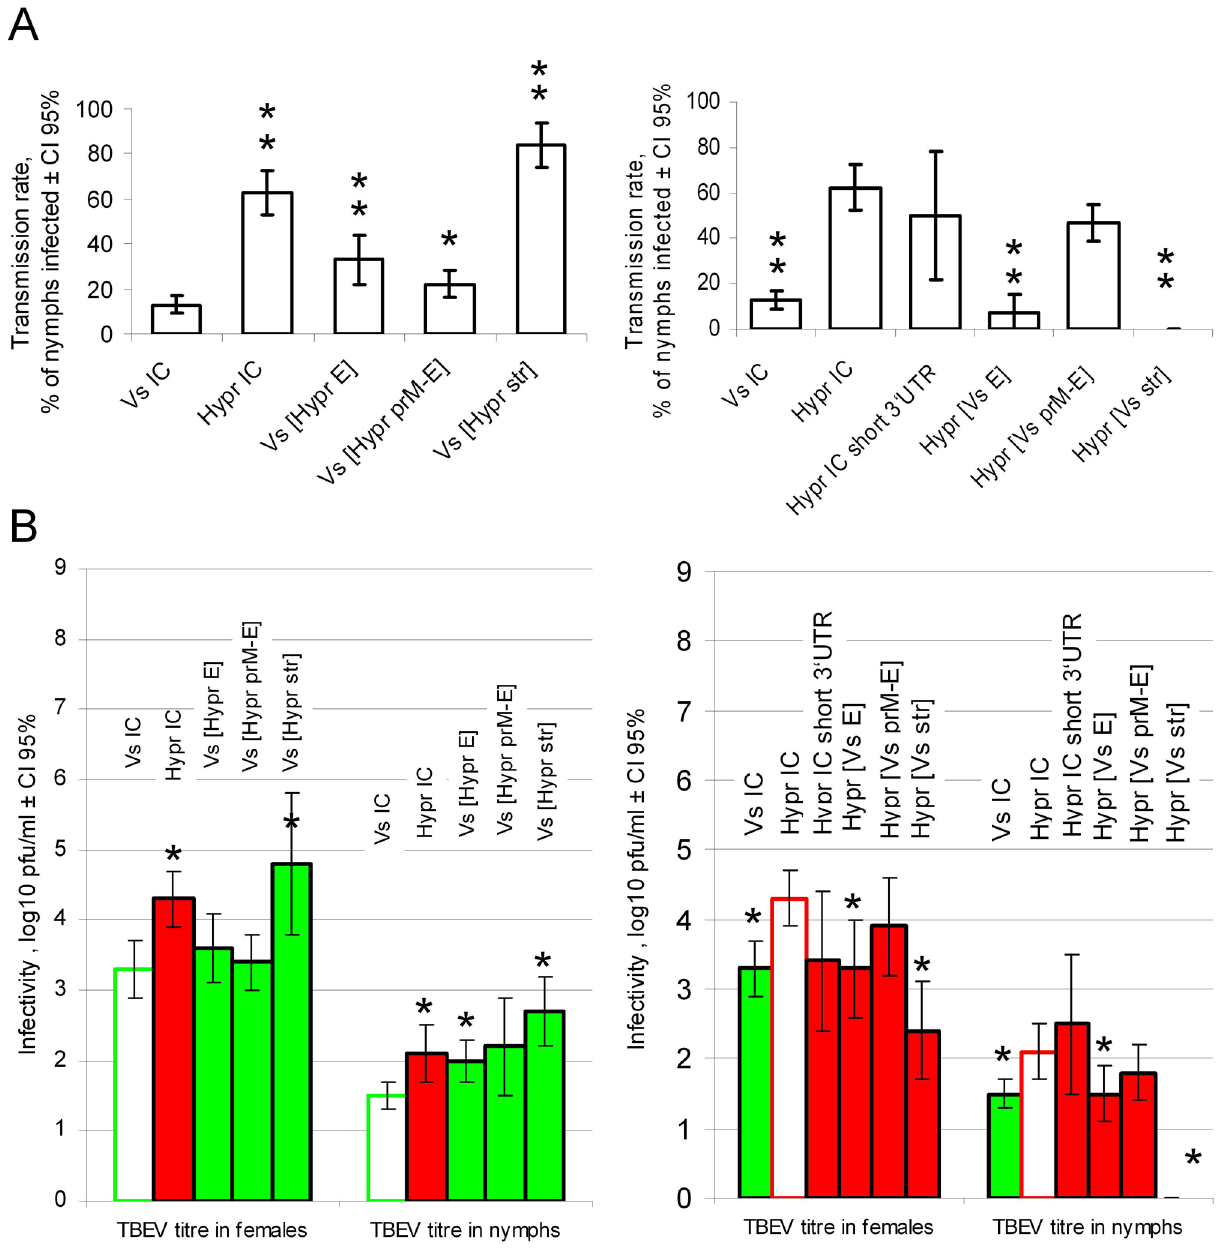
Fig 6. TBEV transmission and replication in I . ricinus ticks. Each adult tick female was injected with 500 pfu of virus (as specified). After 14 days two adult females were co-fed with 15 nymphs for three days and virus titres in females and nymphs were determined by plaque infectivity assay. Left and right panels illustrate biological effects of gene replacements in Vs-based and Hypr-based chimaeras respectively. Mean values are shown with error bars indicating 95% confidence intervals. A) Transmission rate of TBEV between co-feeding ticks is presented as a proportion of nymphs that acquired TBEV infection after co-feeding with infected female ticks. Depending on levels of statistically significant differences (Mann-Whitney test) between chimaeric and control viruses, results are labelled with double (p < 0.01) or single asterisks (p < 0.05). B) Virus titres of TBEV in nymphs and females of I . ricinus . Vs- and Hypr-based chimaeras are identified as green and red bars respectively; the control viruses are shown as empty bars. Highly significant differences (p < 0.05, unpaired two-tailed t-test) between chimaeric and control viruses are labelled with an